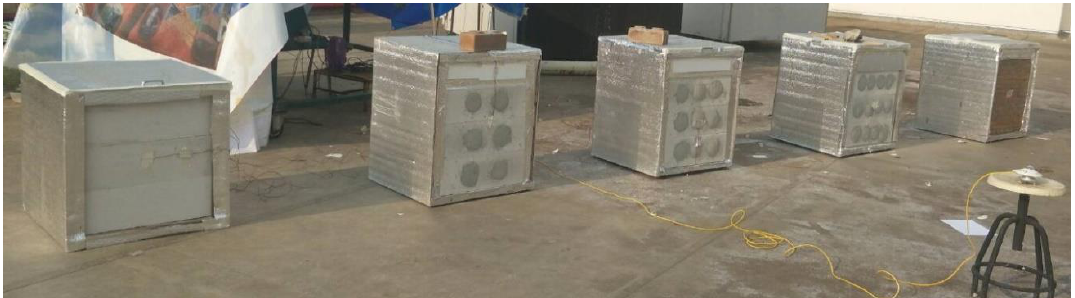
Figure 2. Fixed locations of thermal couples set for testing the time lag and decrement factor of samples.